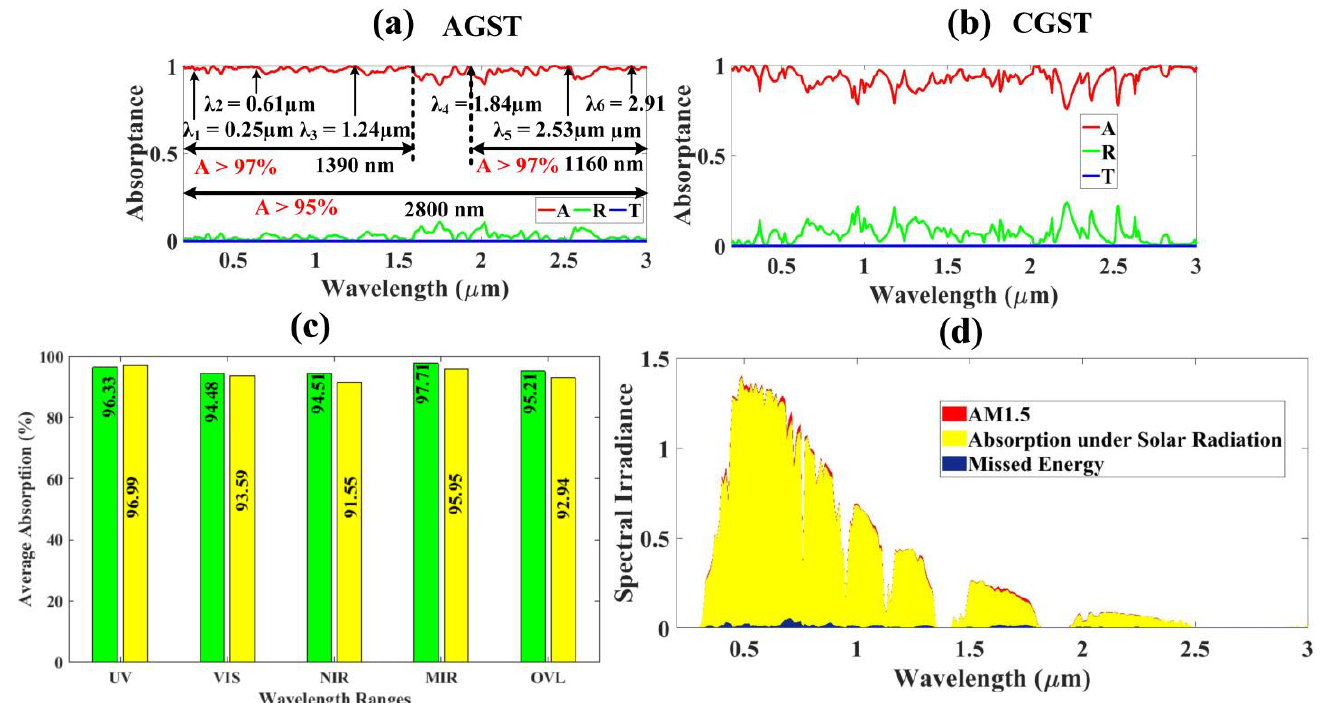
Figure 5. ( a ) The absorption rate of aGST concentric ring resonator solar absorber between 0.2 and 3 µm, ( b ) The absorptance, transmittance, and reflectance of cGST, ( c ) The comparison data plot of absorption rate between aGST in green color and cGST in yellow color for UV, V, NIR, MIR, and overall ranges, ( d ) aGST absorption under solar radiation missed solar energy concerning AM1.5.